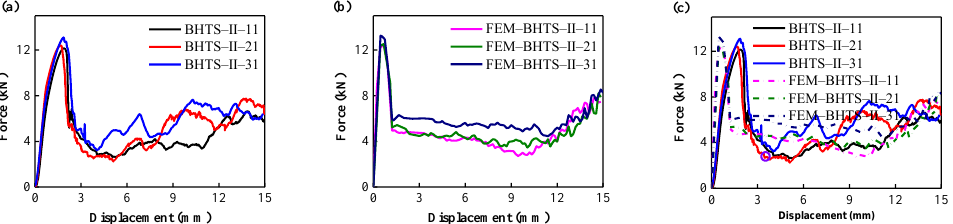
Figure 12. Typical response curves of BHTS – II at each strain rate: ( a ) curves of experimental; ( b ) curves of FEM; ( c ) comparison between experimental and FEM.